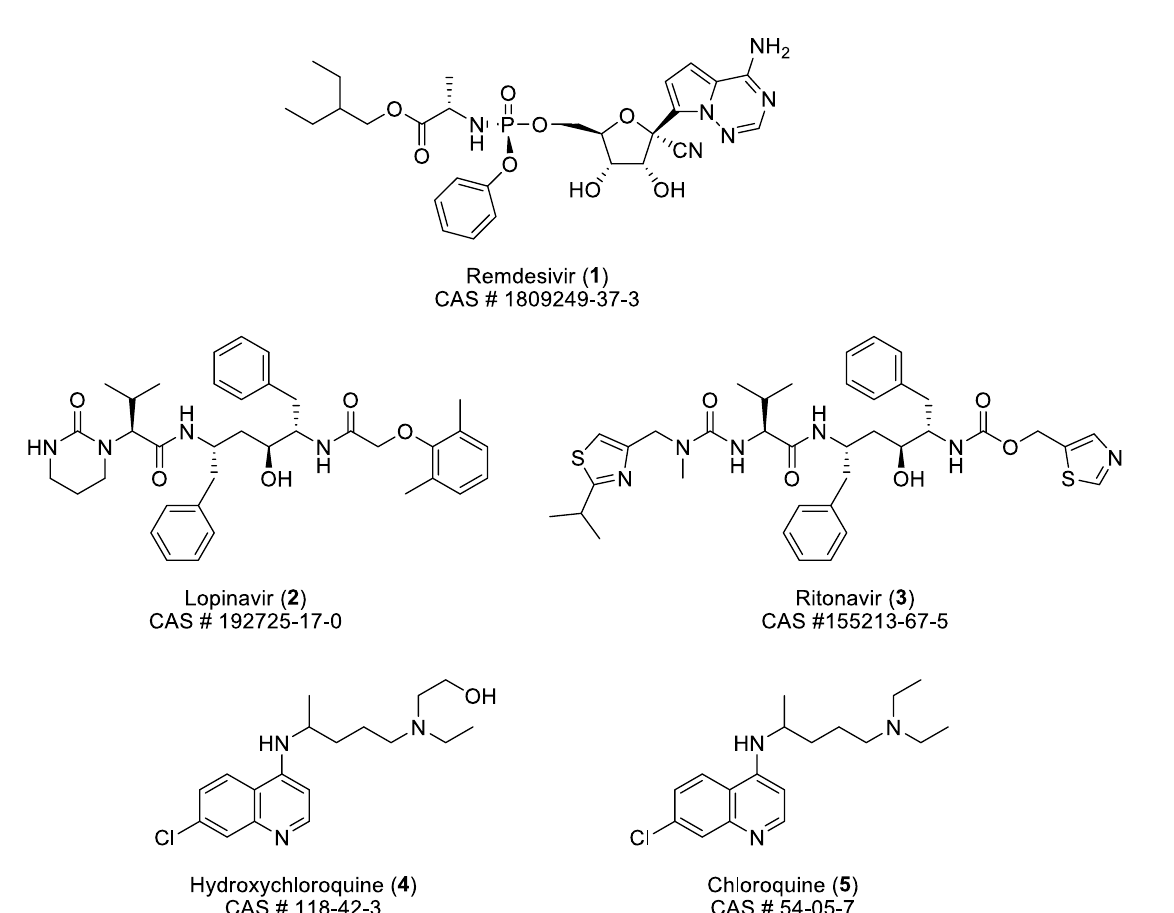
Figure 1. Structure and some characteristics of remdesivir ( 1 ), lopinavir ( 2 ), ritonavir ( 3 ), hydroxychloroquine ( 4 ), and chloroquine ( 5 ).